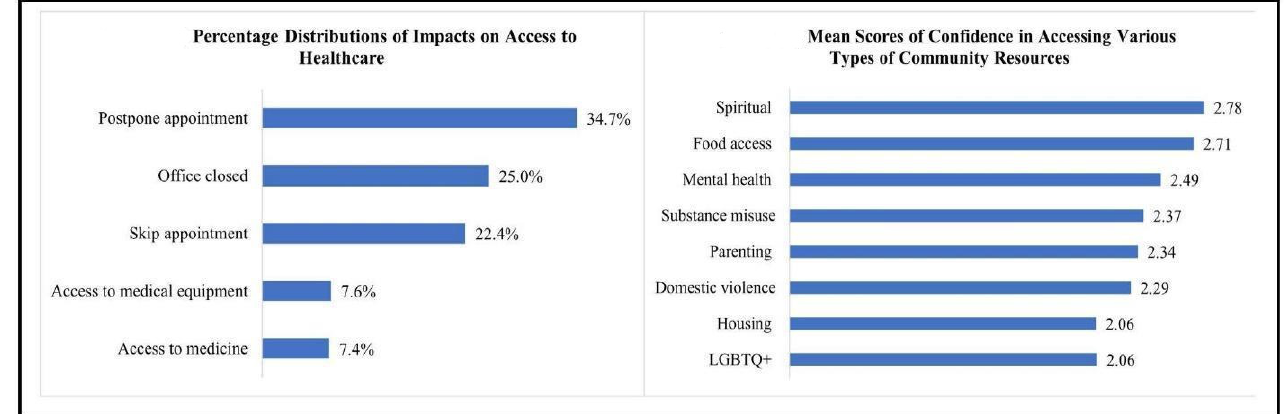
Figure 1. Access to Healthcare and Confidence in Accessing Community Resources during COVID- 19